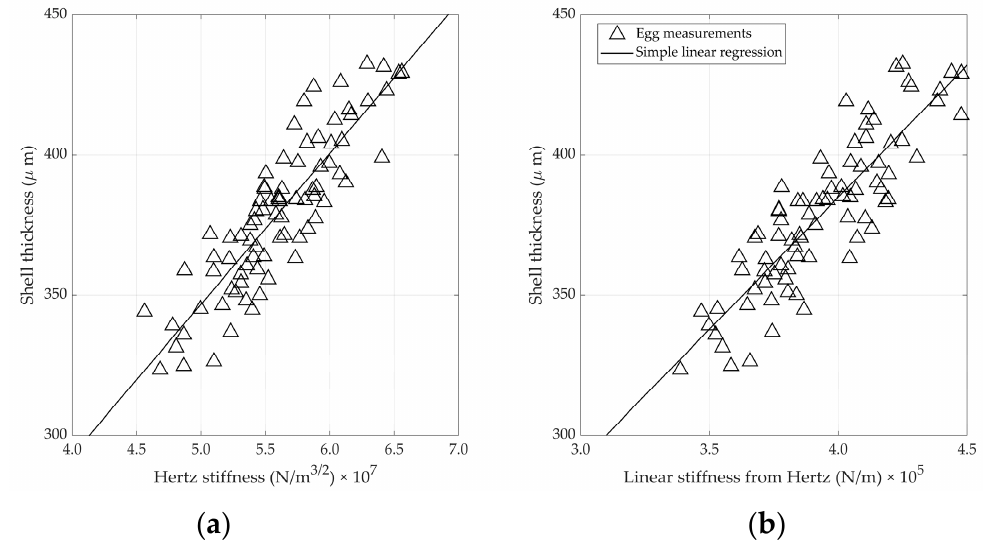
Figure 7. ( a ) Relation between the shell thickness and Hertz stiffness and ( b ) a linear stiffness derived from impact measurements.